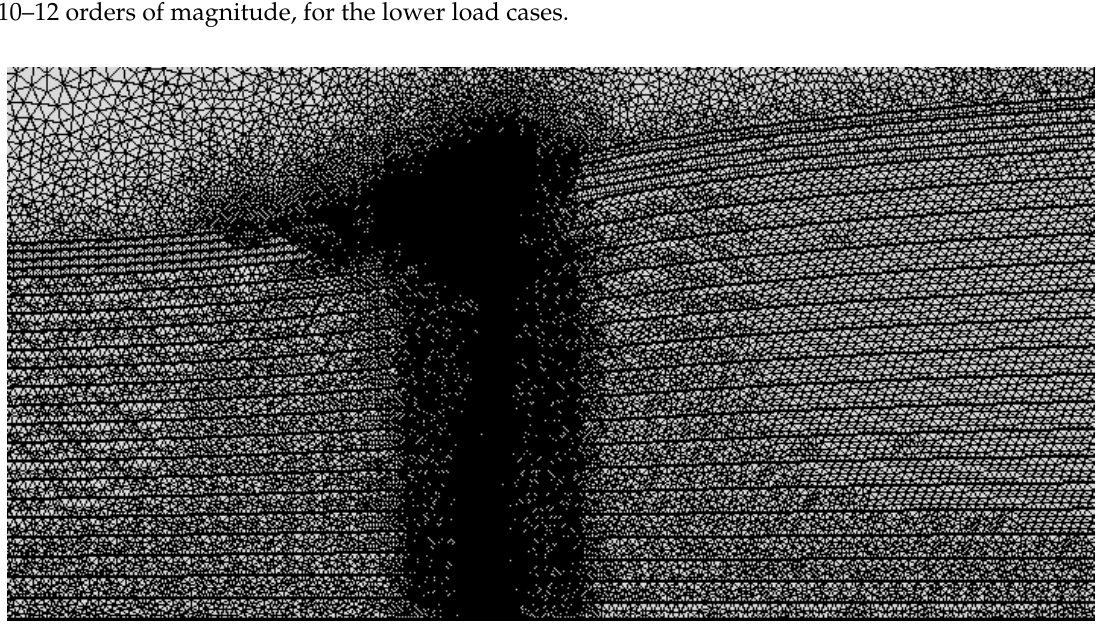
Figure A4. Step 3 zoom-in on mesh topology around disk. Example for λ = 5, C t − blade =